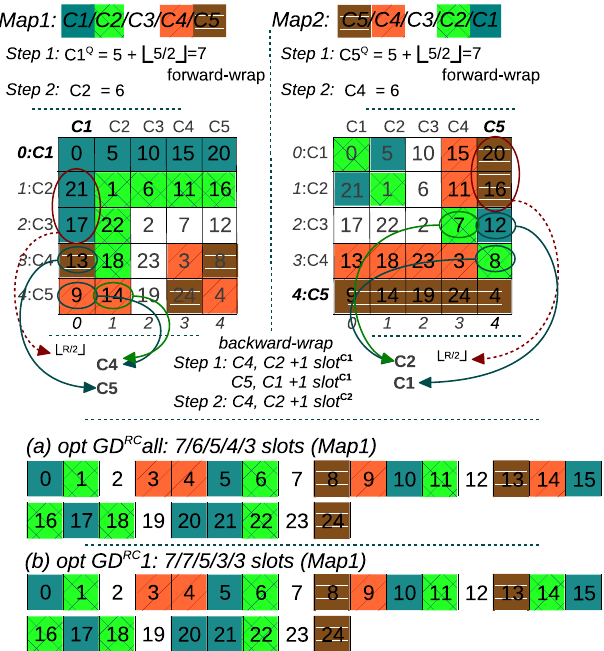
Figure 4. Torus (forward-wrap) way selection in a r × r grid: (a) opt GD RC all and (b) opt GD RC